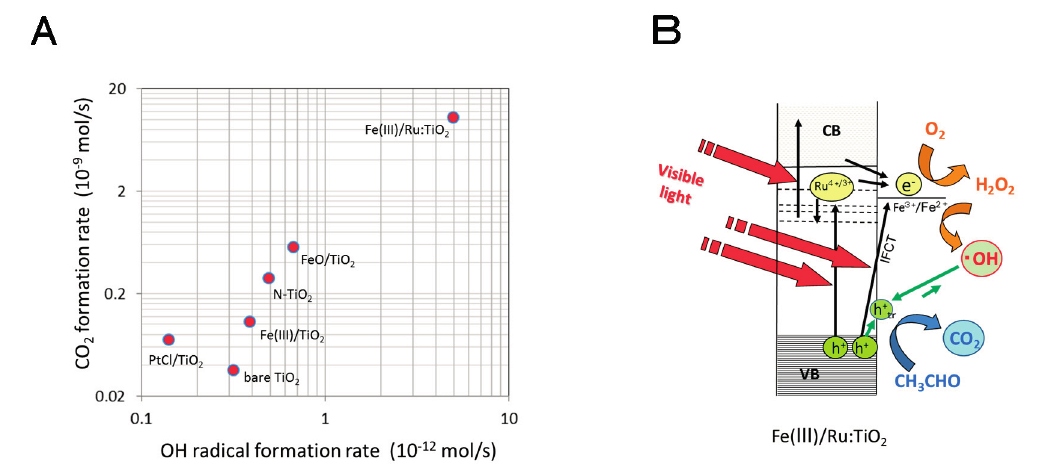
Figure 9. ( A ) Relationship between the formation rates of CO 2 and •OH under the irradiation of 470 nm LED. The CO 2 formation rate is a measure of the photocatalytic reaction rate in the acetaldehyde decomposition in aqueous suspension system; ( B ) Schematic illustration of reaction mechanism of Fe(III)-grafted Ru-doped TiO 2 photocatalyst based on the detection of •OH and CO 2 . Key: IFCT, interfacial charge transfer; h + tr , surface trapped hole. Reprinted with permission from [18]. © 2013 American Chemical